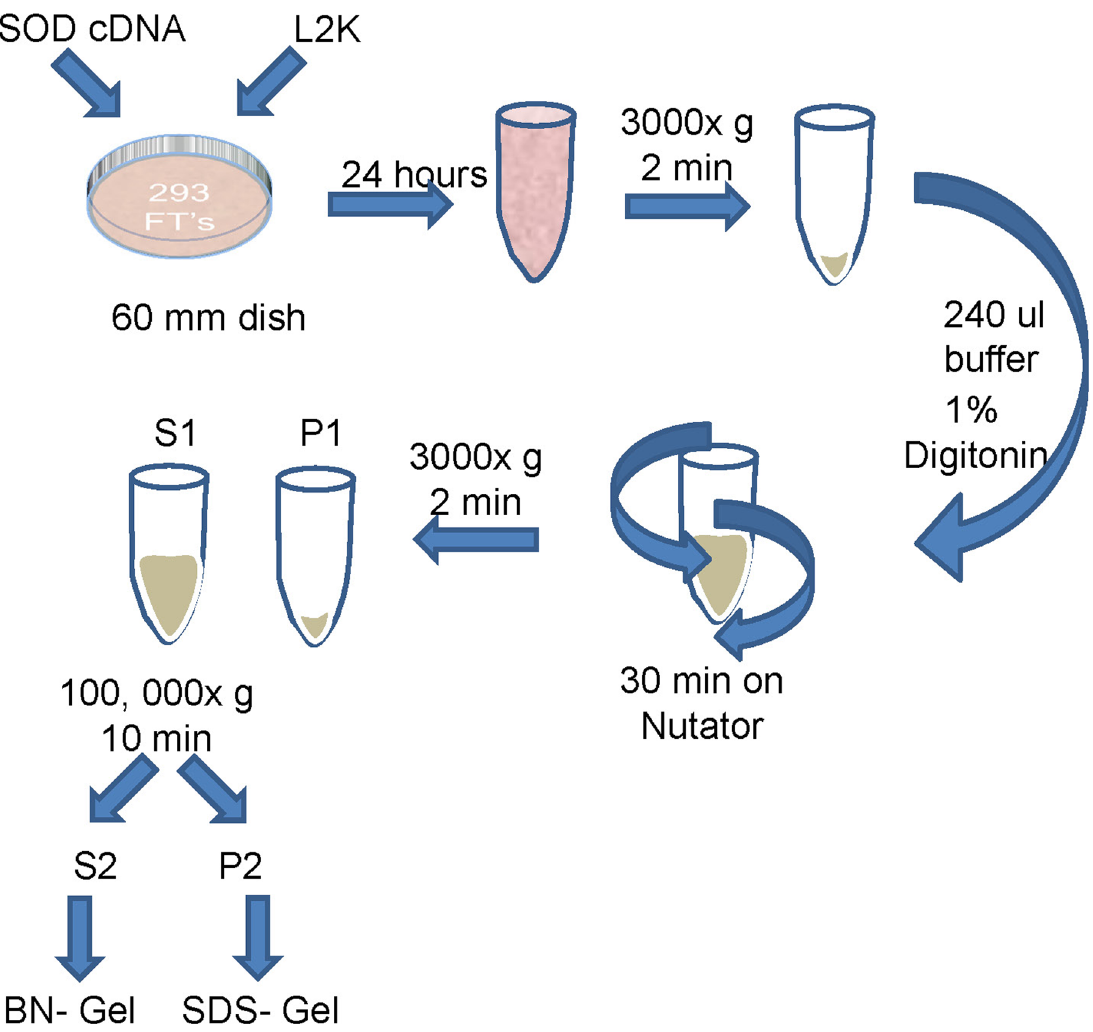
Figure 1. Schematic of the methodology for sample preparation for BN-gels. A detailed description of the methods is provided in the Methods Section.